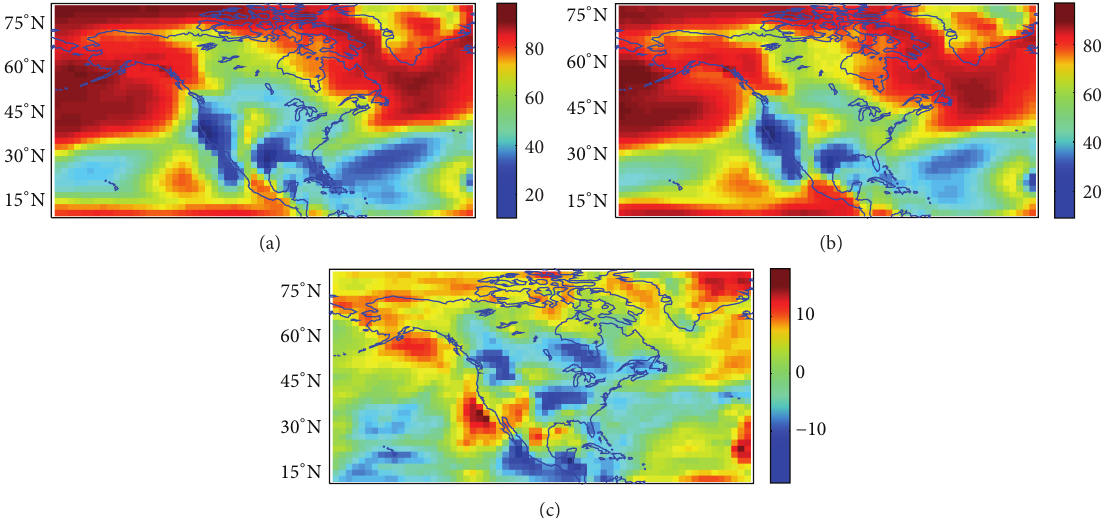
Figure 2: (a) The July climatology of total cloud fraction from the 21st century run with GFDL CM2.0, based on 2080–2100 average. (b) The same as (a) but from the 20th century run, based on 1980–2000 average. (c) The trend, defined as (a) minus (b). The color scales with units in percentage are shown on the